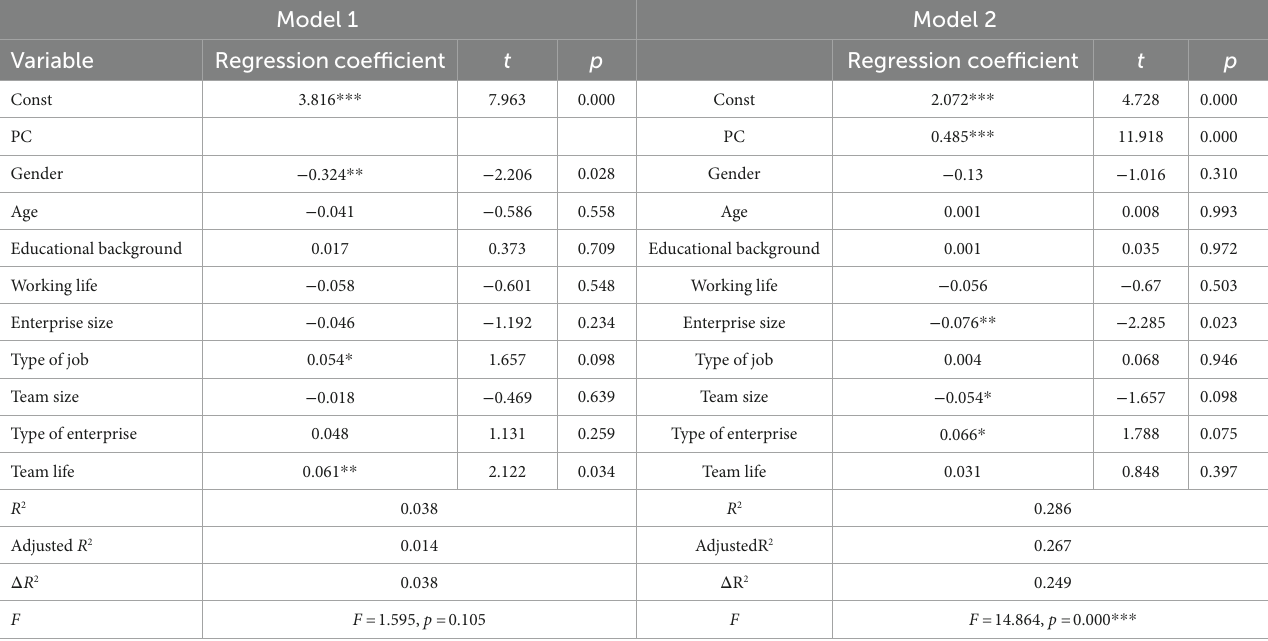
TABLE 6 Hierarchical regression analysis of Psychological Capital and Breakthrough Innovation.